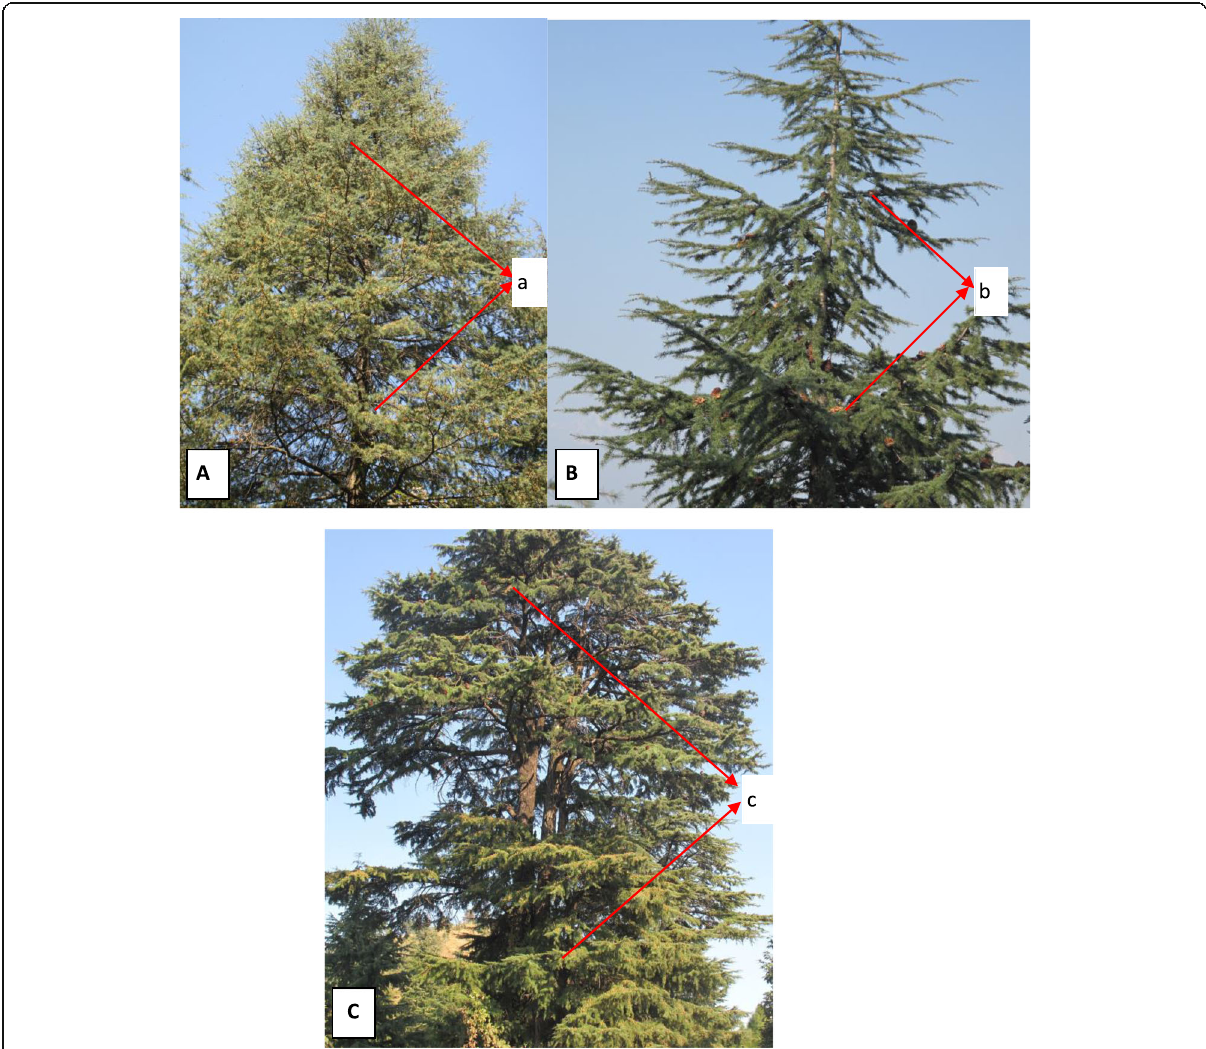
Fig. 2 Sex expression in Cedrus deodara . A Male tree (a: Cluster of male cones developed all over the canopy layers). B Female tree (b: Female cone development all over the canopy layers). C Monoecious tree (c: Male and female cone development within a tree)